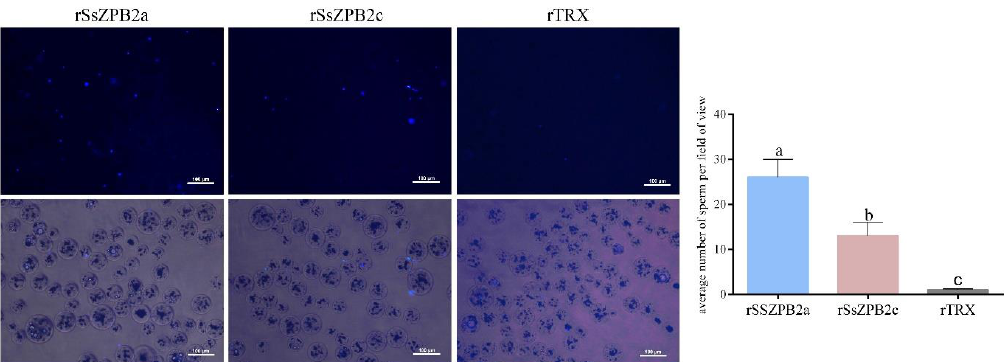
Figure 4. The sperm could bind to the surface of magnetic bead incubated with rSsZPB2a and rSsZPB2c. At least 10 fields of view were selected for each group, and each field of view contained at least 30 magnetic beads. The Data are presented as mean ± SD (n = 10 for each group). Values with different superscripts indicate statistical significance ( p < 0.05). Scale bar, 100 μm. Values with different low letters indicate statistical significance ( P < 0.05) after one-way ANOVA analysis. Next, we would like to investigate the detail location where rSsZPB2a and rSsZPB2c bind to sperm. According to the distribution of green fluorescence, we could confirm that both rSsZPB2a and rSsZPB2c bound at the partial posterior end of spermatozoa head (Figure 5). Likewise, the higher binding activity is found between rSsZPB2a and spermatozoa (Figure 5). Furthermore, Western blot assay proved the positive binding activity of rSsZPB2a rather than rTRX to the sperm in black rockfish (Figure S3). Taken together, all these results indicated that rSsZPB2a and rSsZPB2c could bind to the sperm in vitro.